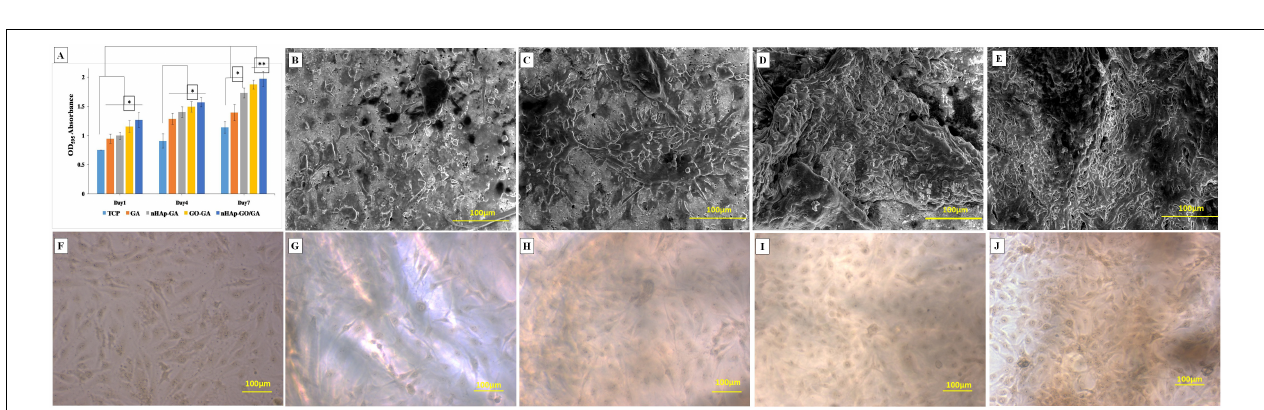
FIGURE 3 | Biological characterization of GA, nHAp-GA, GO-GA, and nHAp-GO/GA nanocomposite scaffolds: MTT assay (A) , EESEM images of GA (B) , nHAp-GA (C) , GO-GA (D) , and nHAp-GO/GA (E) . Optical images at day 7 after cell culture for TCP (F) , GA (G) , nHAp-GA (H) , GO-GA (I) , and nHAp-GO/GA (J) . Error bars and columns represent standard deviation and means. ** p < 0.005 and * p < 0.05 indicate statistical difference.